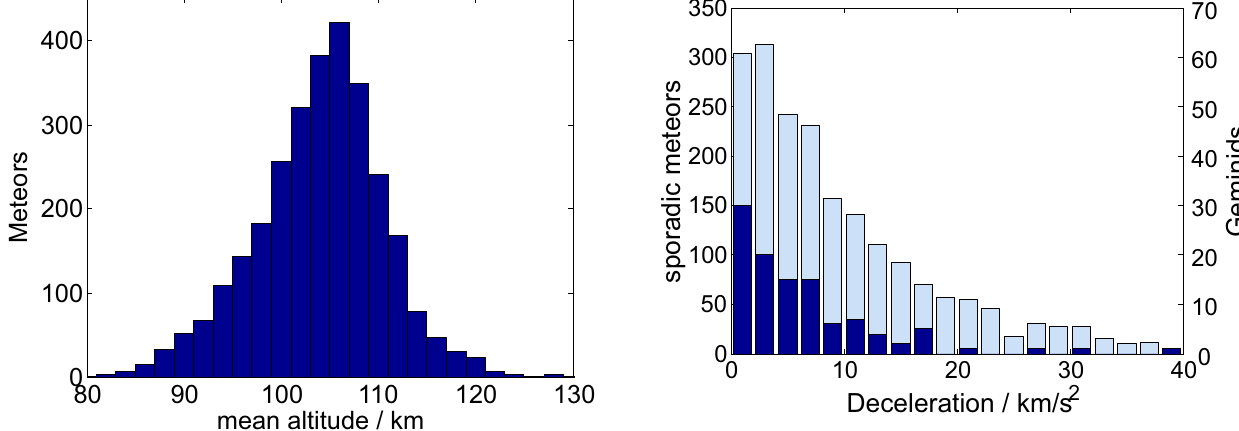
Fig. 11. Histogram of the mean meteor-head echo altitudes.